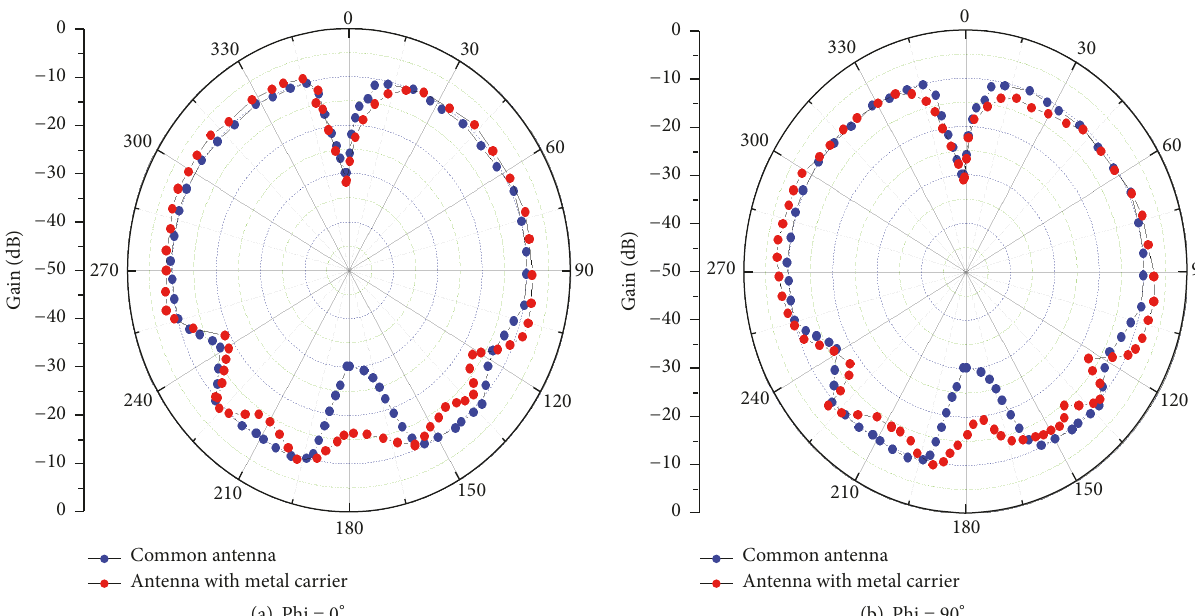
Figure 13: Influence of UAV material on radiation performance of vertical polarization unit.